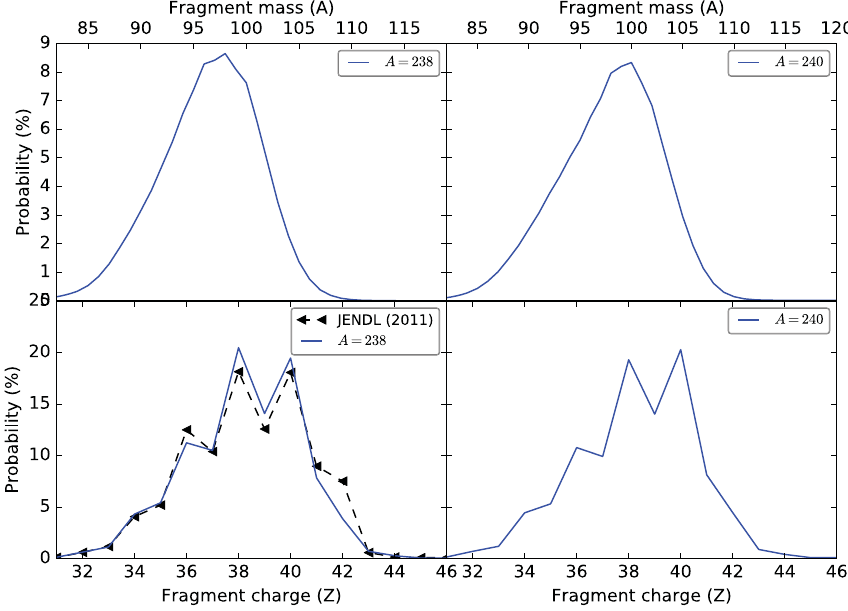
Figure 3. Same as figure 2 for the reactions 239 U(n,f) (left) and 241 U(n,f)